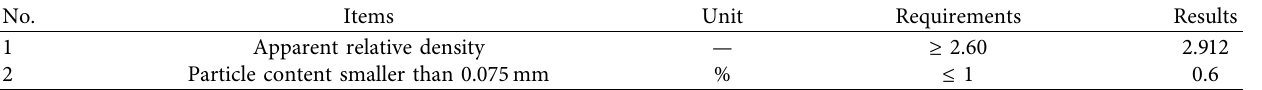
Table 3: Technical properties of limestone machine-made sand.